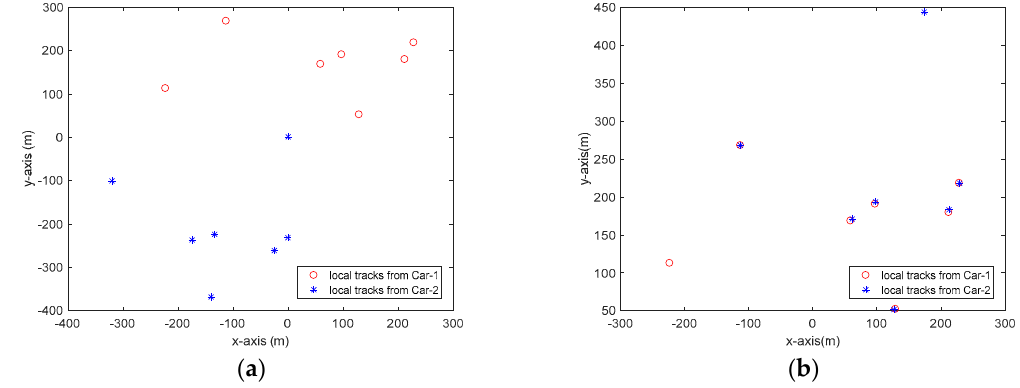
Figure 5. Illustration of local tracks from Car-1 and Car-2 at time step k = 57. ( a ) Before association; ( b ) After association. Table 1. Absolute error (AE) of state estimation.